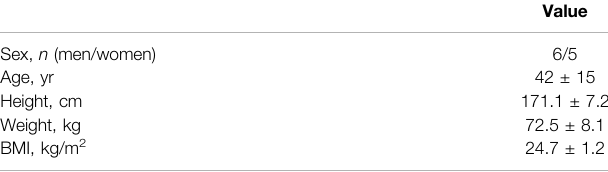
TABLE 1 | Participant